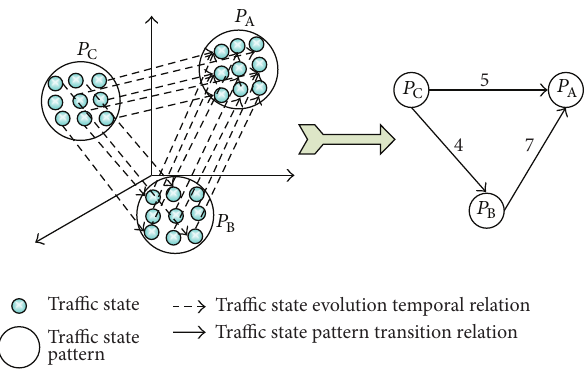
Figure 1: The structure diagram of